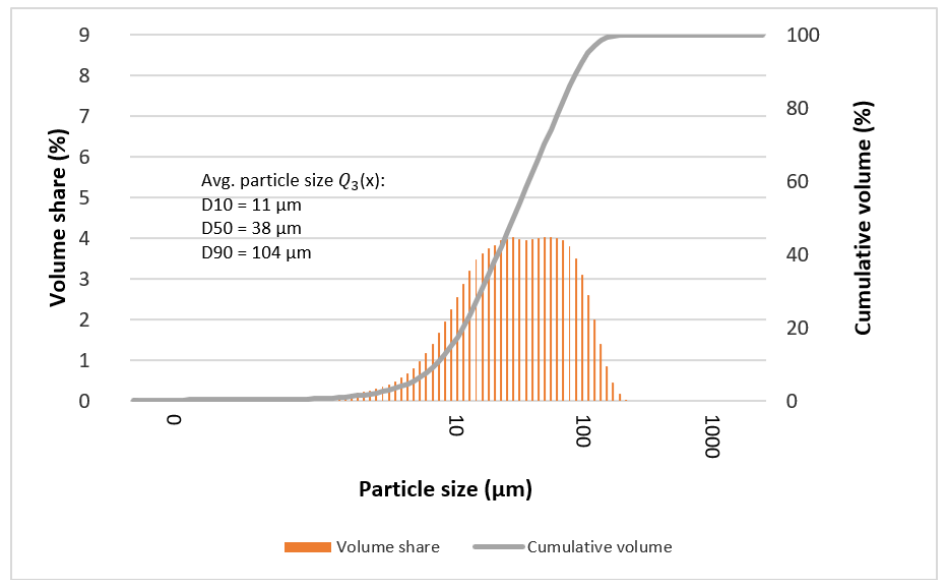
Figure 11. Graphs of particle size distributions (histograms) and their cumulative distribution (curve) for Mg 64 Zn 30 Ca 4 Ag 2 alloy after 50 milling hours.